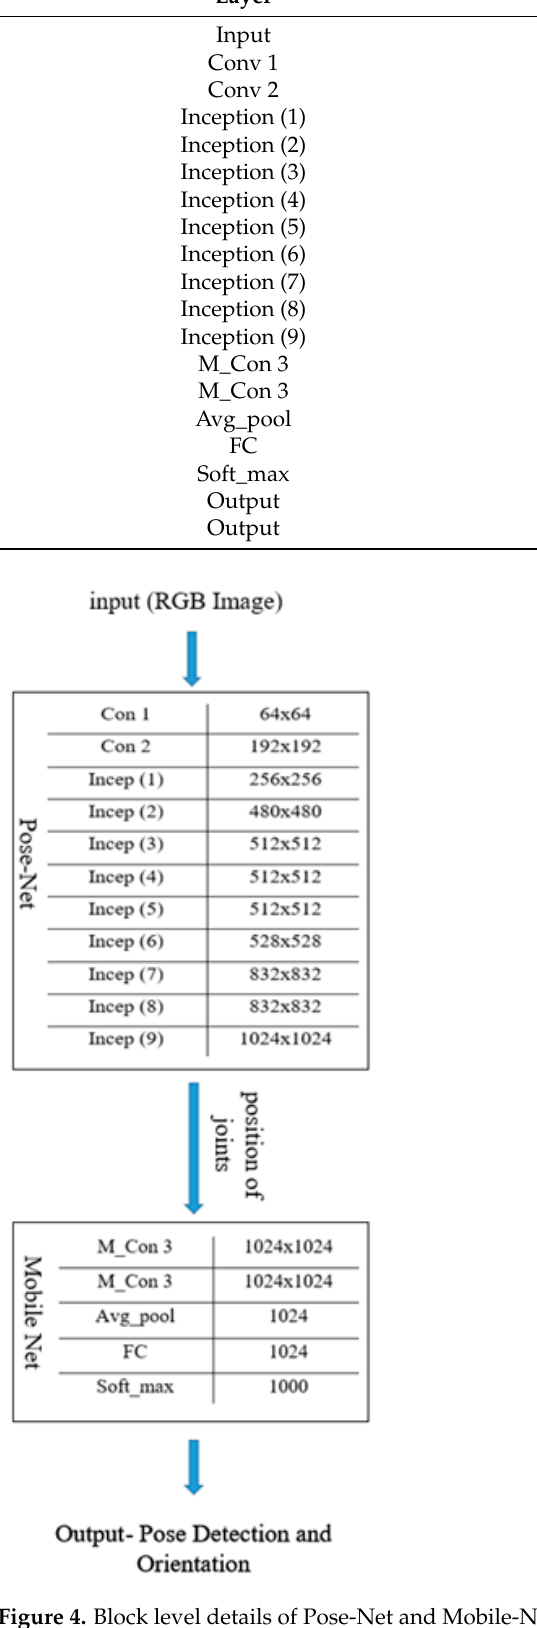
Figure 4. Block level details of Pose-Net and Mobile-Net and their respective output. The input image is fed into the convolution layer (Con), where the edges are enhanced and embossed. Then, the output of convolution layer is fed to the Inception Layer (Incep), where a combination of layers (namely, 1 × 1 Convolutional layer, 3 × 3 Convolutional layer, 5 × 5 Convolutional layer) with their output filter banks concatenate the input into a single output vector (position of joints), which acts as an input of the next layer. The convolution layer of Mobile-Net (M_Con3) handles the output vector for depth- wise convolution. The separated output vectors are further fed into the average pooling layer (Avg_pool), which reduces the dimensions. In the fully connected layer, the output of the previous layer is multiplied with a weighted matrix and a bias vector is added. Finally, the soft max layer (soft_max) converts the vector scores based on the normalized probability distribution to detect the pose of the subject along with its orientation. Figure 5 shows the detailed structure of each layer in the proposed model for determining the right yoga posture.